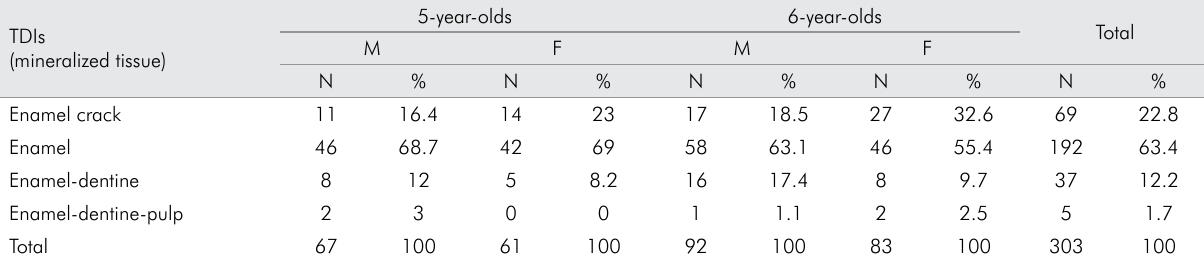
Table 1. Absolute and percentage distribution of children affected by type of coronary tissue trauma in primary teeth according to age and